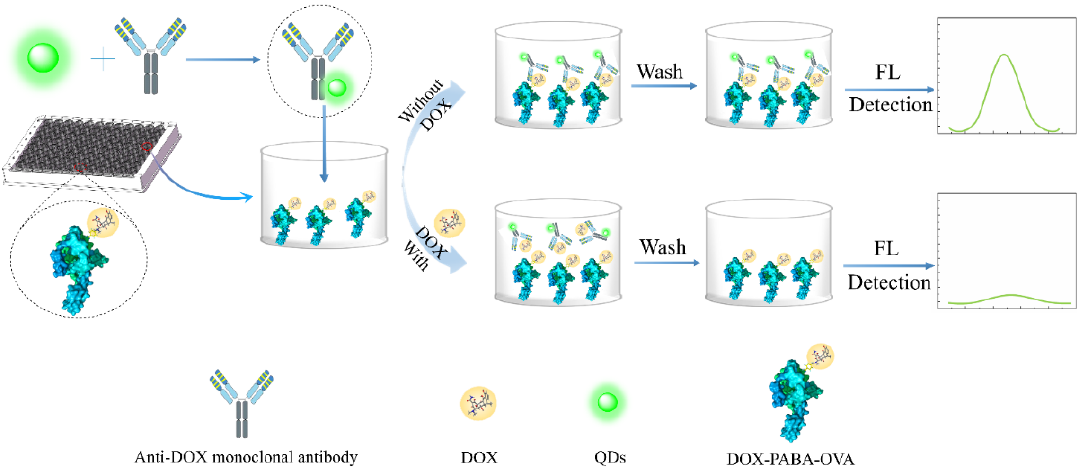
Figure 1. Schematic diagram of QD-cFIA.